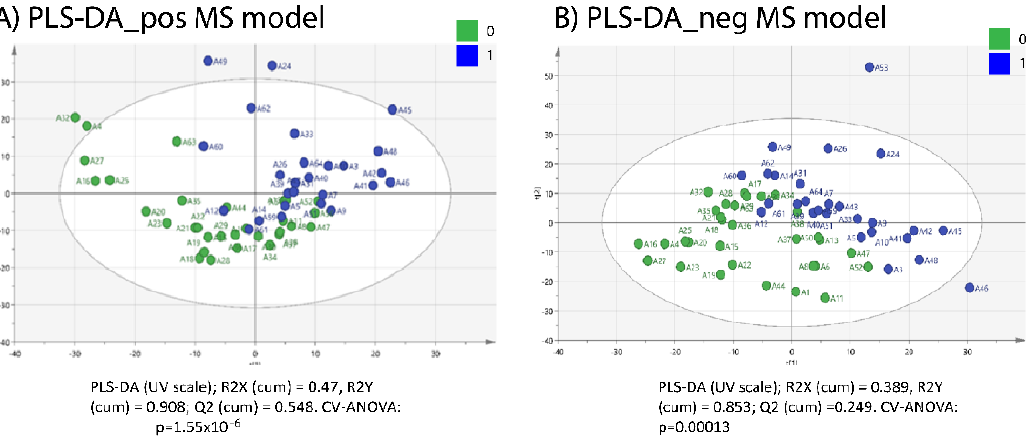
Figure 1. CV-validated PLS-DA models/score plots in ( A ) positive ion mode, and ( B ) in negative ion mode showing adequate separation between the two groups (healthy = 0, in green and inflammation = 1, in blue) based on their untargeted metabolomics profile in sow urine. Each dot represents a sow urine sample (n = 58 in total).